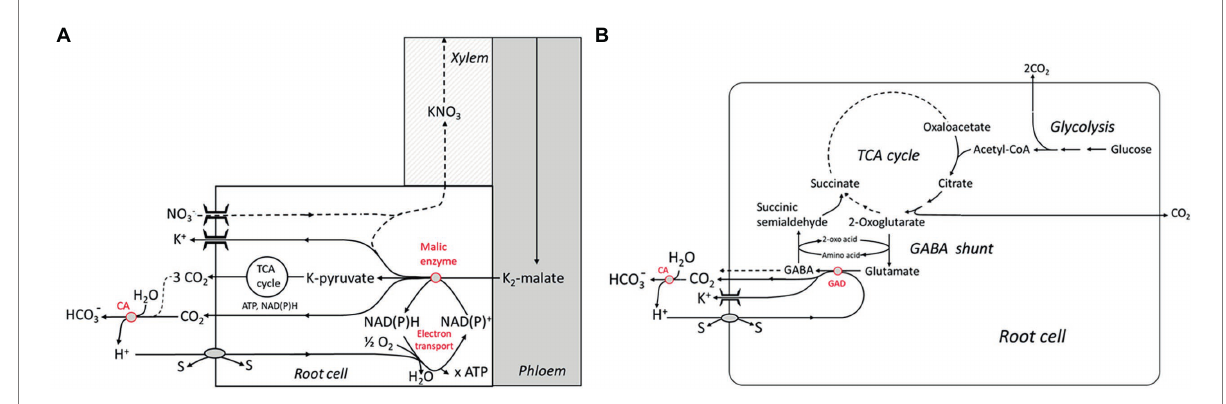
FIGURE 3 Metabolic schemes showing “active” buffering in the cytosol by malic enzyme and the electron transport chain (A) and the glutamate decarboxylase (GAD) which is part of the 4-Aminobutyric acid (GABA) shunt (B) . Both systems are capable of capturing H + imported by cotransport with or antiport against other substrates (“s”). Extracellular buffering is brought about by the carbonic anhydrase (CA). TCA, tricarbonic acid. Reproduced from Wegner and Shabala (2020), with